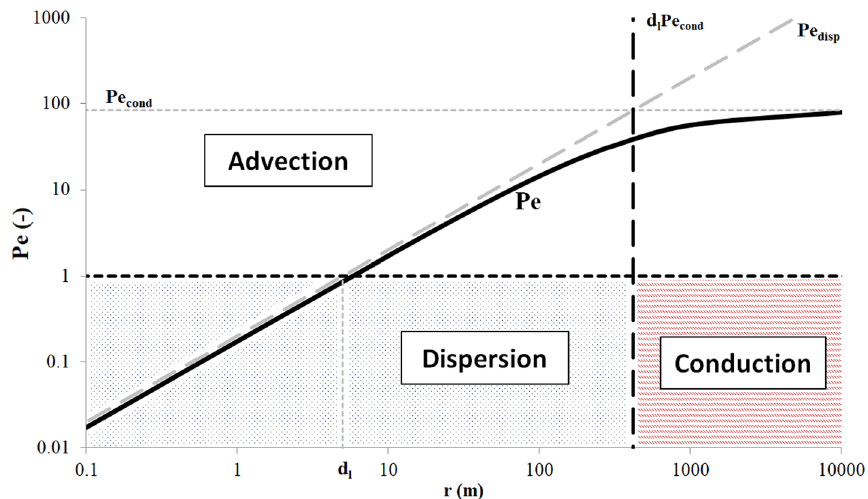
Fig. 3 Perfect radial Pe assuming a purely radial injection